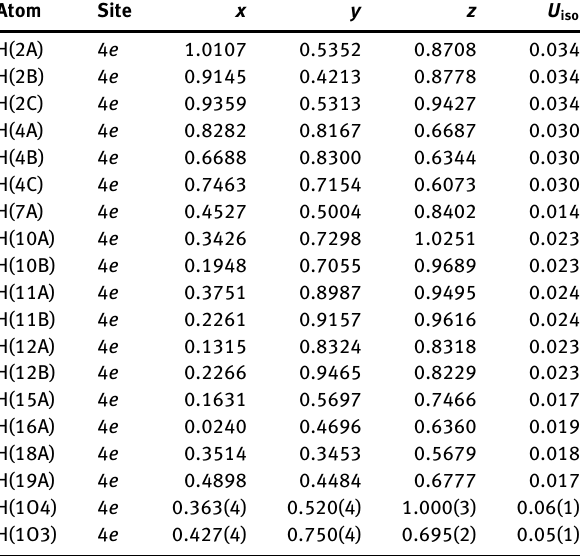
Table 2: Fractional atomic coordinates and isotropic or equivalent isotropic displacement parameters (Å 2 ).